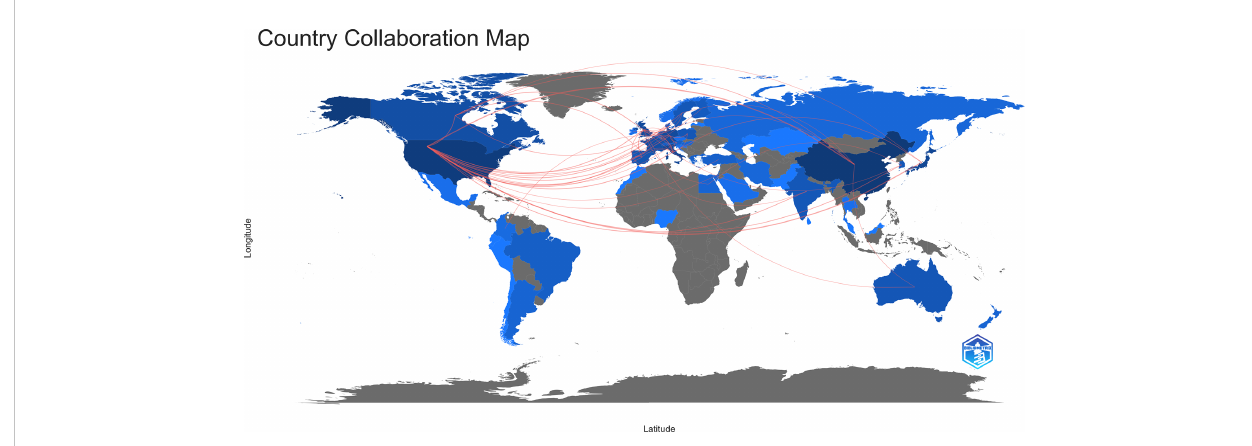
FIGURE 7 National and regional collaborations in the fi eld of osteosarcoma metabolism as shown by the Bibliometrix package using R language